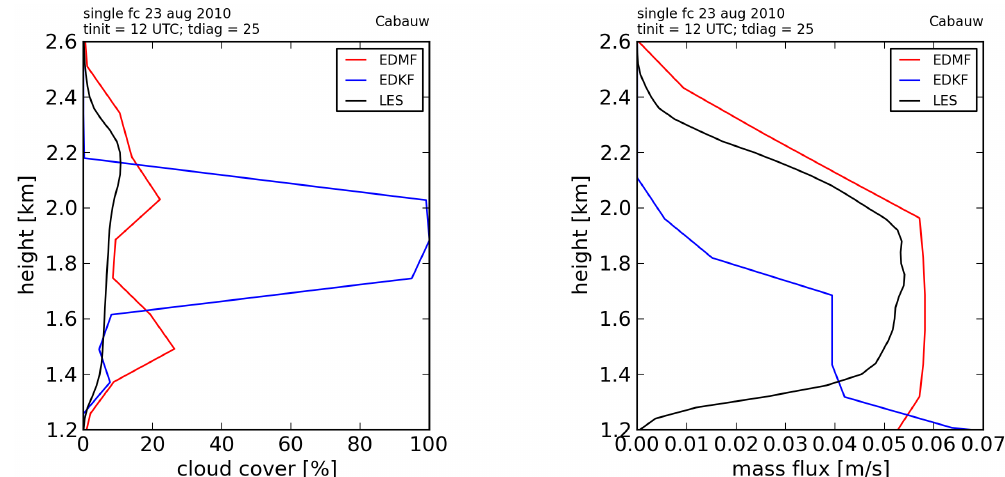
Figure 3. Profiles of cloud fraction (right) and mass flux(left) at t =+ 25h, validation time 24th of August 2010 1300 UTC. Note that the cloud base height is at approximately 1.4 km